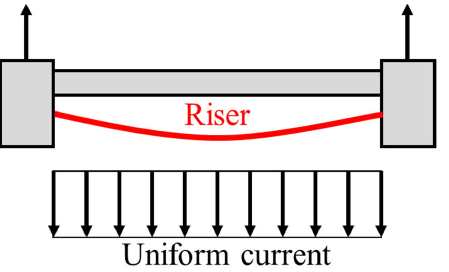
Figure 15. Uniform flow condition through towing equipment. Table 5. Parameters of tensioned riser model with uniform current.